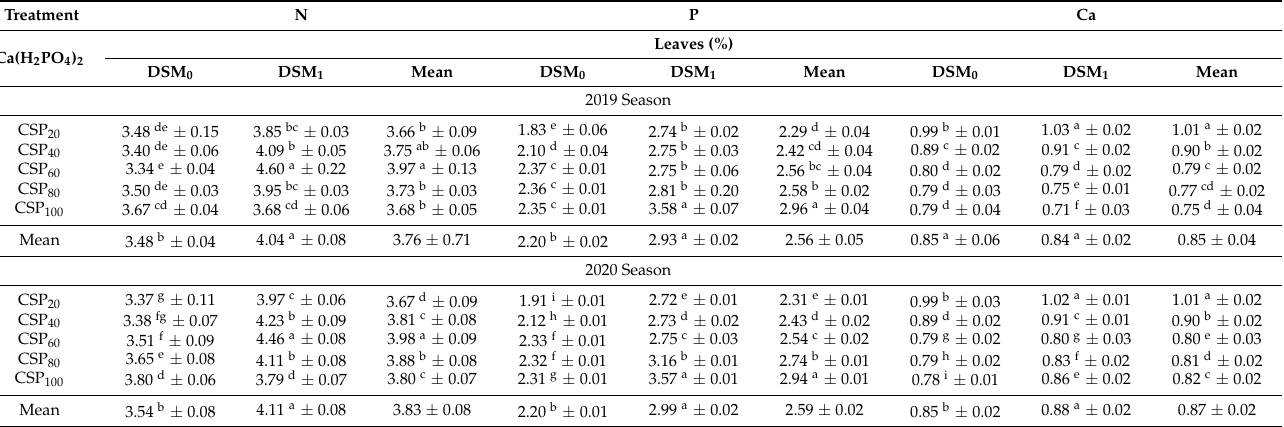
Table 4. Influence of calcium superphosphate (CSP) levels, Bacillus megaterium DSM 2894 var. and their interactions on some leaf nutrients content of CaCO 3 -stressed sweet potato plants in 2019 and